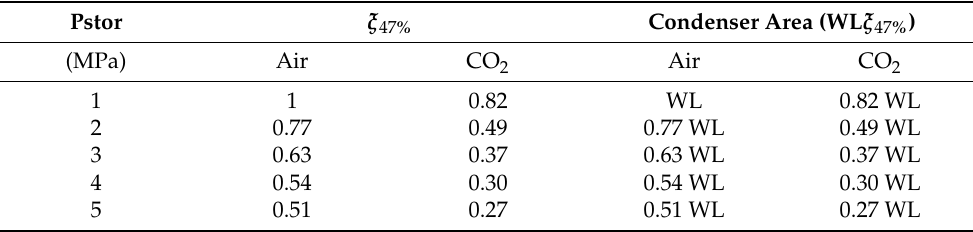
Table 3. Condenser length, ξ 47% , and condenser area, WL ξ 47% , required for 47% of vapor content to be